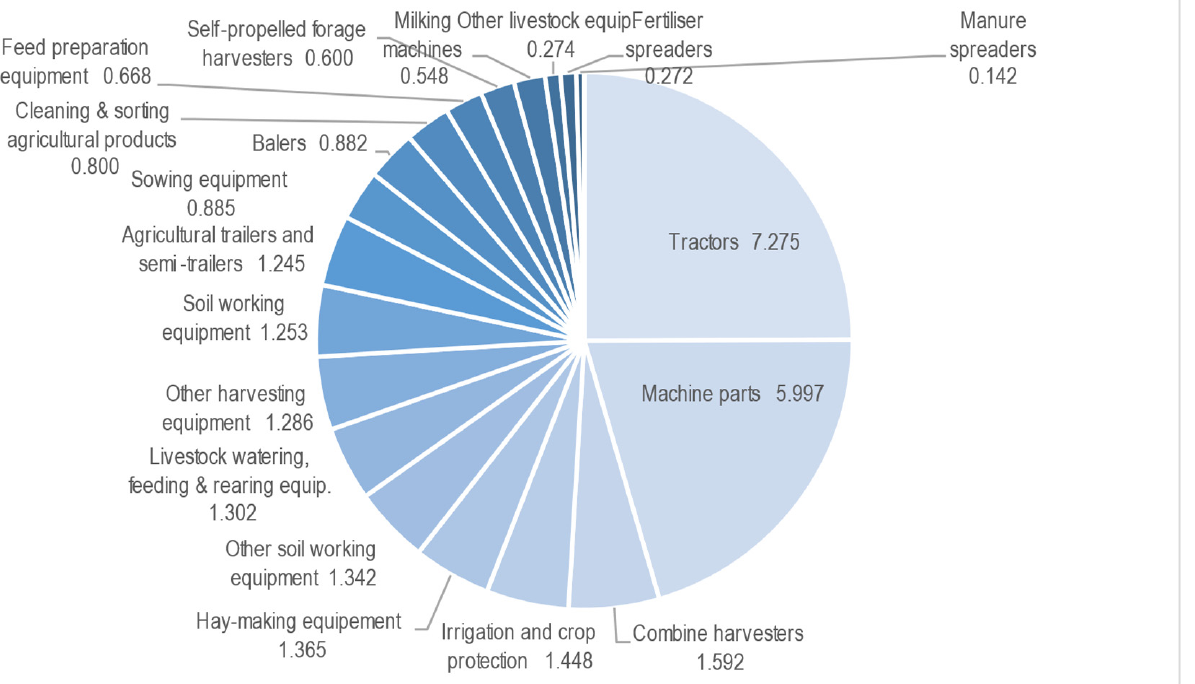
Figure 1. European (EU 27) agricultural machinery production (in thousands of million EUR) by product family in 2020.